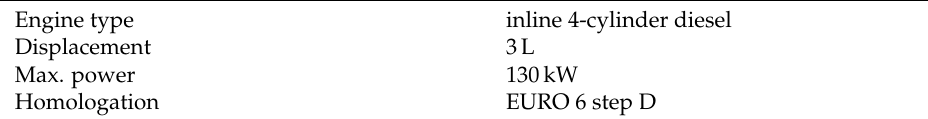
Figure 1. Schematic of engine system layout. The aftertreatment system (ATS) features a diesel oxida- tion catalyst (DOC), a diesel particulate filter (DPF), and a selective catalytic reduction (SCR) system. Table 1. Main characteristics of the engine